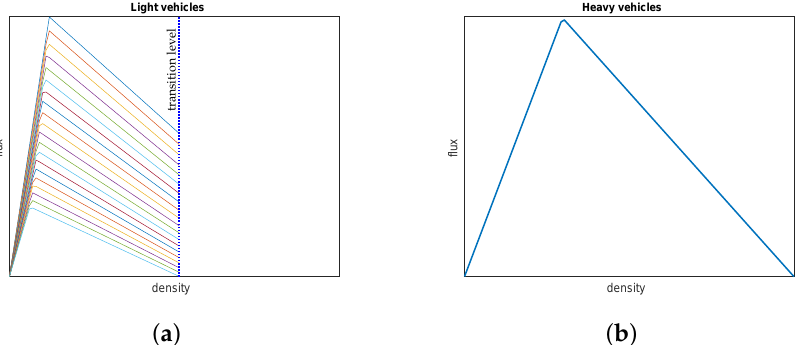
and of the macroscopic model (9). D 1 D 2